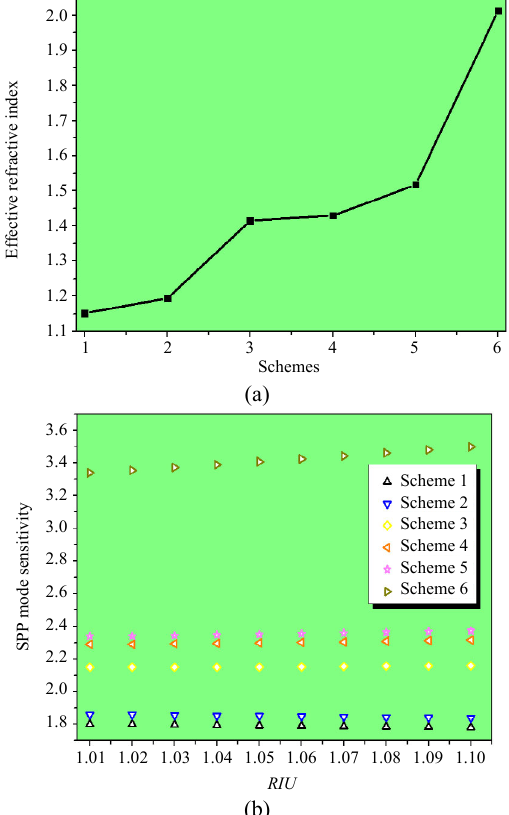
Fig. 4 Effective refractive index and mode sensitivity analysis (a) real part of n eff of the SPP mode and ( b) SPP mode sensitivity.